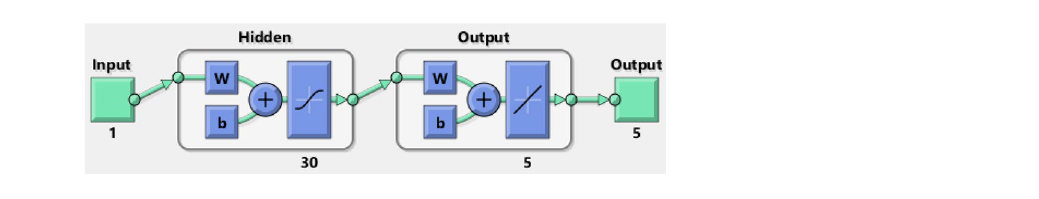
Figure 4. Architecture of neural